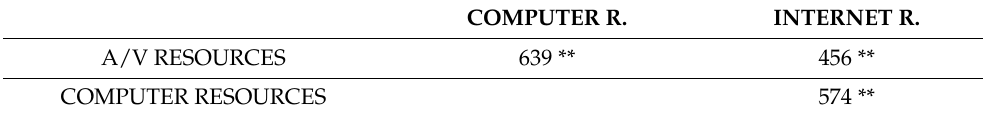
Table 9. Correlations between the different technological mastery areas. (note: ** = significant at 0.01). COMPUTER